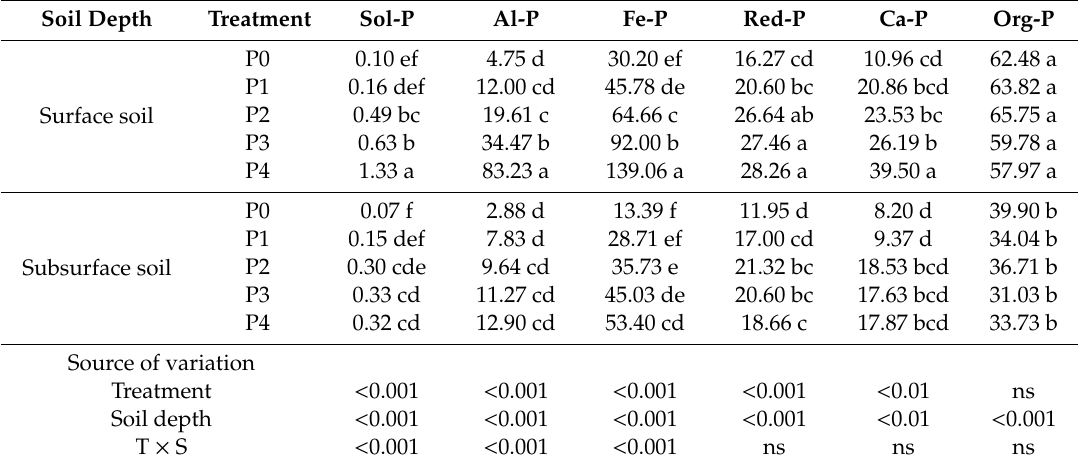
Table 3. Soil P fractions come from field experiment under sequential extractions (mg · kg − 1 ). Soil Depth